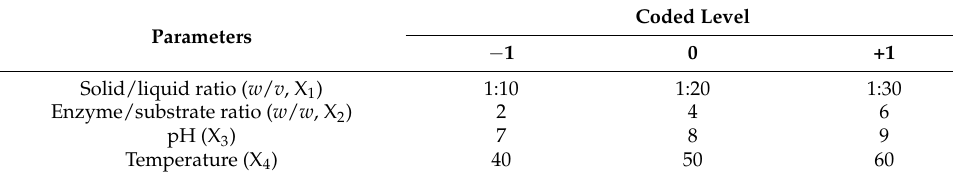
Table 1. Independent variables, their coded and actual levels used in RSM for optimizing enzymolysis conditions using alcalase and trypsin. Coded Level Parameters − 1 0 +1 Solid/liquid ratio ( w / v , X 1 )